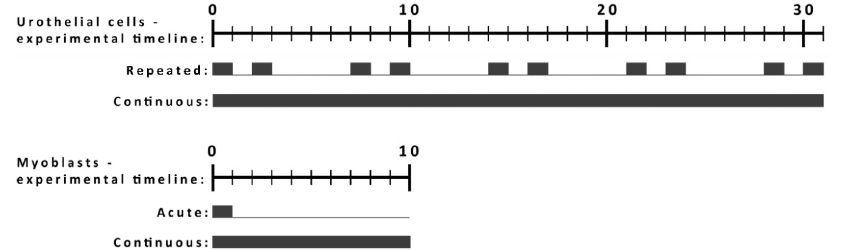
Figure 1. Schematic representation of the exposure protocols for the long-term studies. Long-term nanotoxicity studies were performed using normal porcine urothelial (NPU) cells and rat L6 cells. Cells were exposed to NPs as indicated in the scheme: a full line denotes NP exposure, while an empty line means cell culturing in the absence of NPs. NPU cells were grown for 31 days and exposed to NPs either 2 days per week (repeated) or continuously for 31 days (continuous). L6 cells were grown for 10 days and were exposed to NPs either only on the first day (acute) or for 10 days (continuous) during their differentiation.